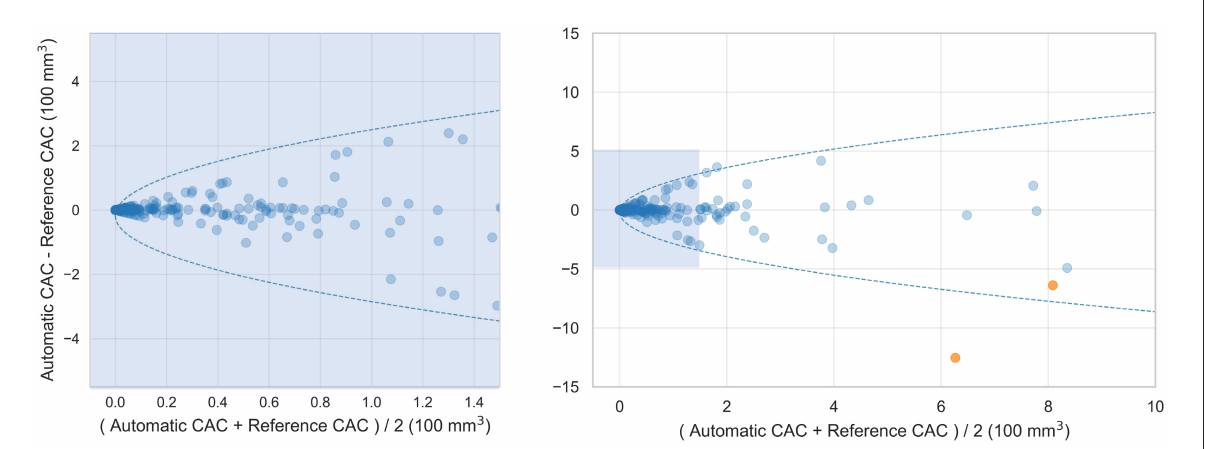
FIGURE3 Bland-Altman plots comparing automatically detected CAC volume with the manual reference volume. 95% limits of agreement are represented by the formula: Difference = ± 1.96 × ( π/ 2) 0.5 × ( b + a × Mean 0.5 ), with a = 10.9 and b = − 17.8. Two outlier cases are colored orange. The Bland-Altman plot of lesions with volume less than 150 mm 3 is shown on the left and all lesions is shown on the